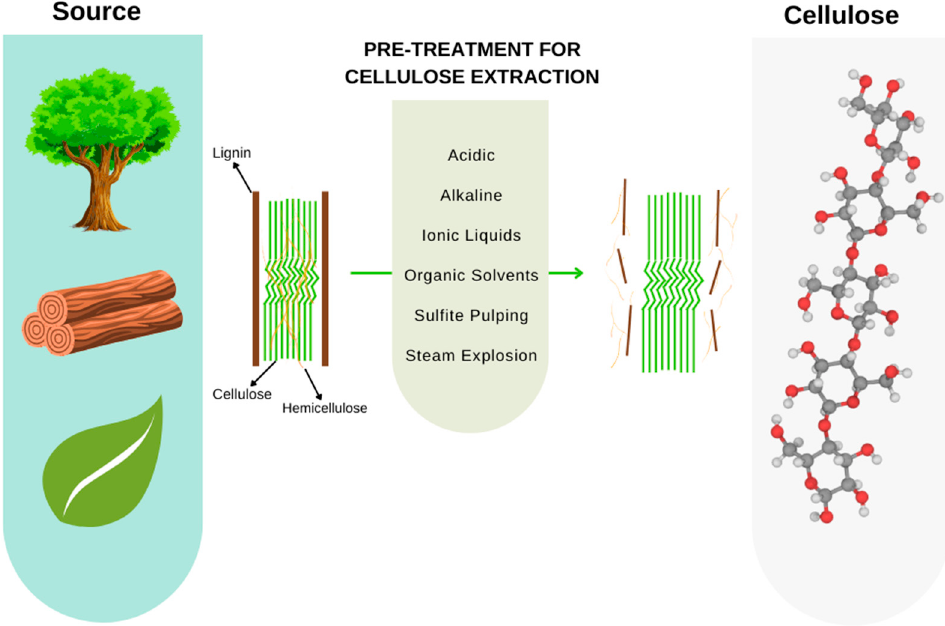
Figure 6. Lignocellulosic biomass: sources, extraction processes, and cellulose structure (Adapted with permission from Ref. [4]. Copyright 2015, Elsevier).